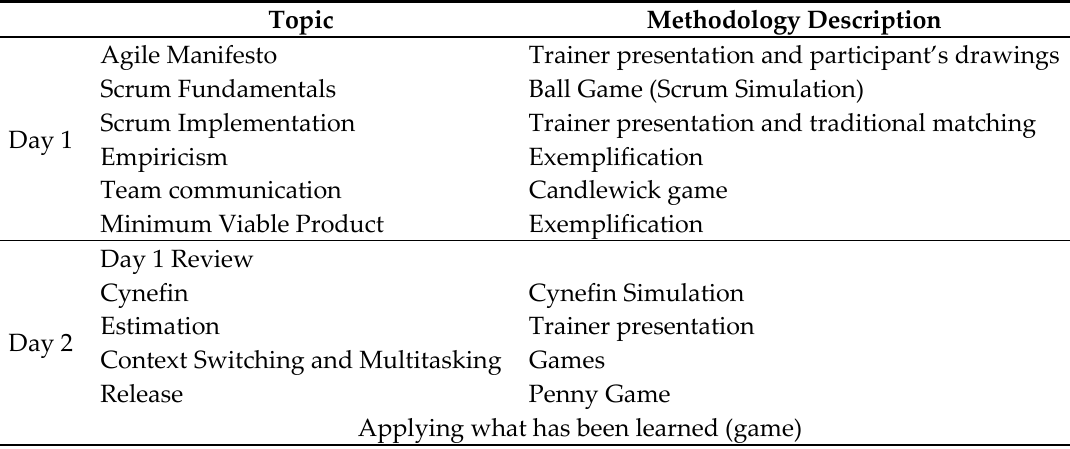
Table 1. Scrum Fundamentals and Scrum Master Workshop Design.